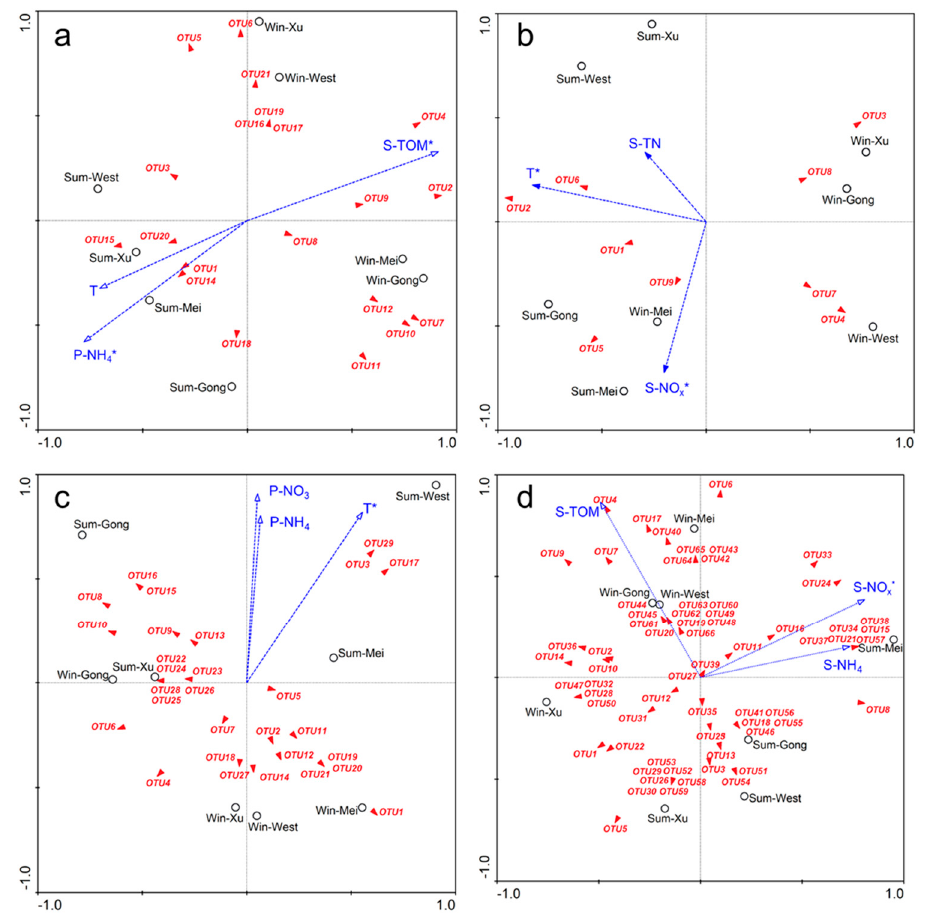
Figure 8. Canonical correspondence analysis (CCA) ordination plots for the relationship between ammonia-oxidizing bacteria ( a ), ammonia-oxidizing archaea ( b ), anammox bacteria ( c ), denitrifying bacteria ( d ) community composition with the environmental parameters in the different lake regions of Lake Taihu.